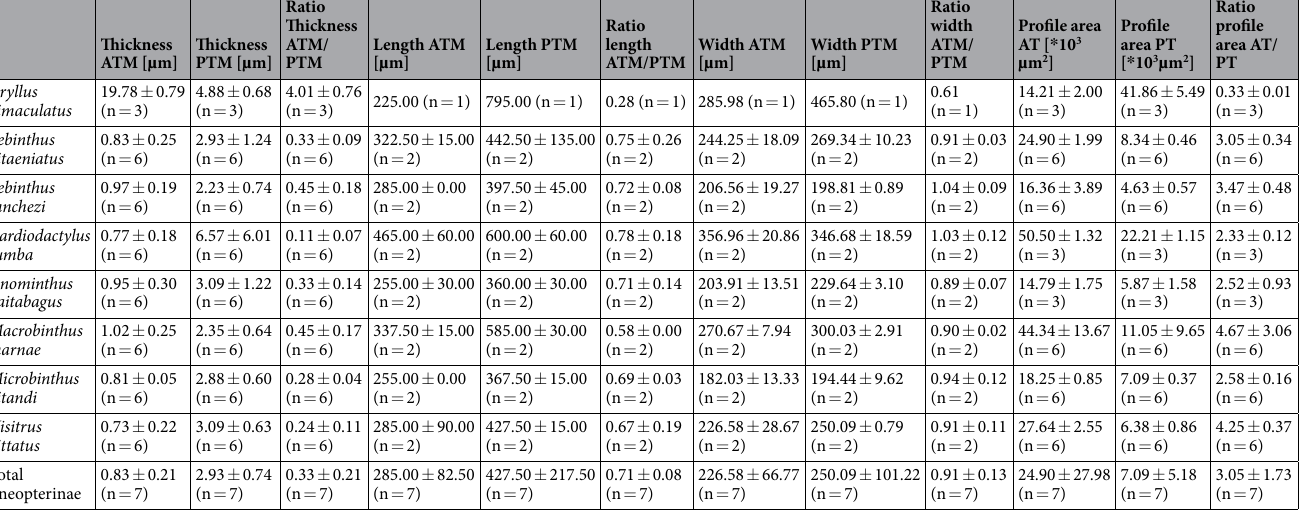
Table 1. Measured parameters of the tympanal organs of the different species investigated. Given are median values ± interquartile ranges. The number of individual measurements is given in brackets. Abbreviations: AT = anterior tracheal branch; ATM = anterior tympanal membrane; PT = posterior tracheal branch; PTM = posterior tympanal